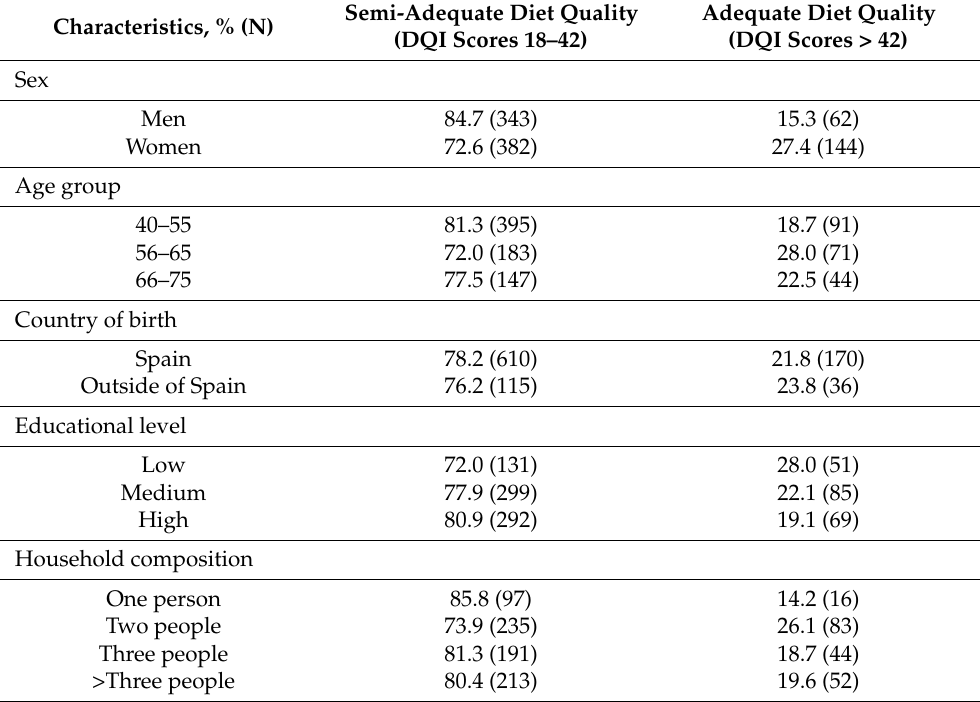
Table 1. Sample characteristics by diet quality in Madrid from 2017 to 2021 (n =